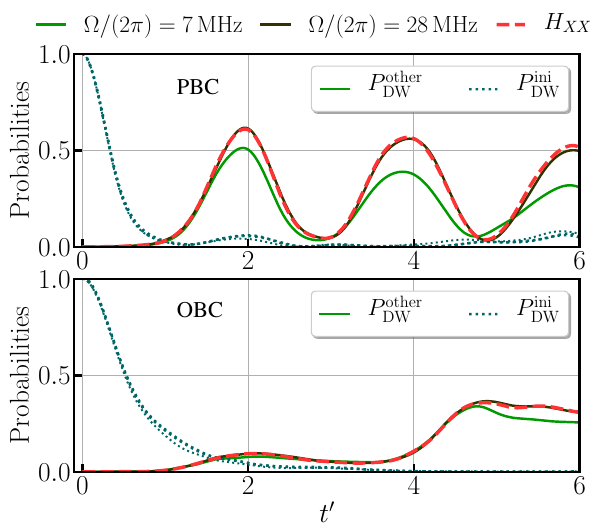
FIG. 6. The influence of the finite duration of the microwave pulses. A comparison between the evolution of the probabili- ties of domain walls under H driven and H XXX in PBCs (upper) and OBCs (lower). The simulations do not include any exper- imental error to highlight the role of the finite duration of the microwave pulses, with average Rabi frequency (cid:4) . The large increase of P DW observed for t (cid:12) > 4 in OBCs is a consequence of the reflection of the excitations at the edges of the